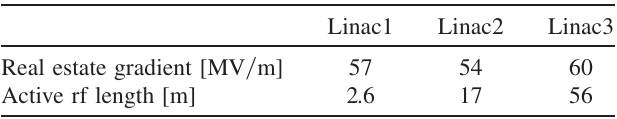
TABLE I. The rf parameters of each